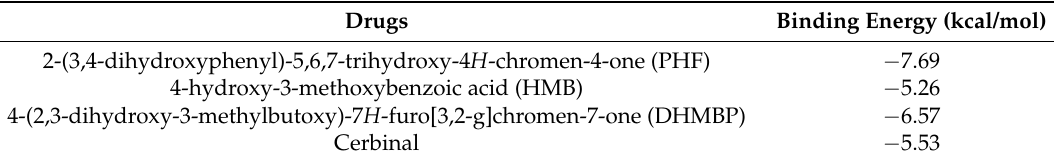
Table 1. The binding energy of drugs in docking.